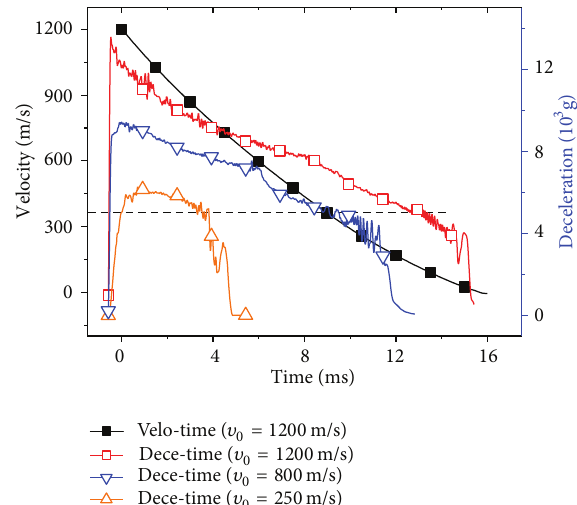
Figure 3: Deceleration and velocity versus time (23MPa concrete, HJC model).